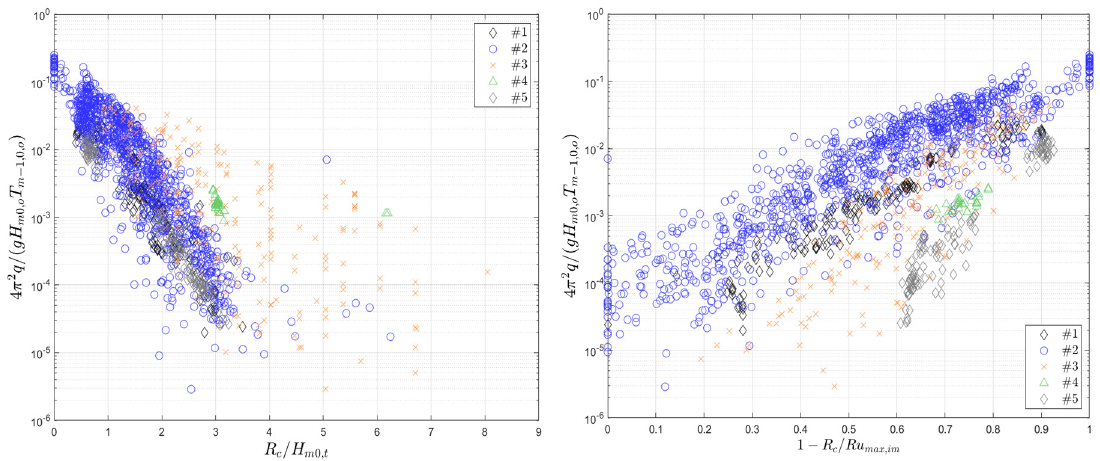
Figure 4. Variation of the dimensionless overtopping Q * discharge versus with the dimensionless freeboard (left) and deficit in freeboard (right) for each of the five employed datasets.